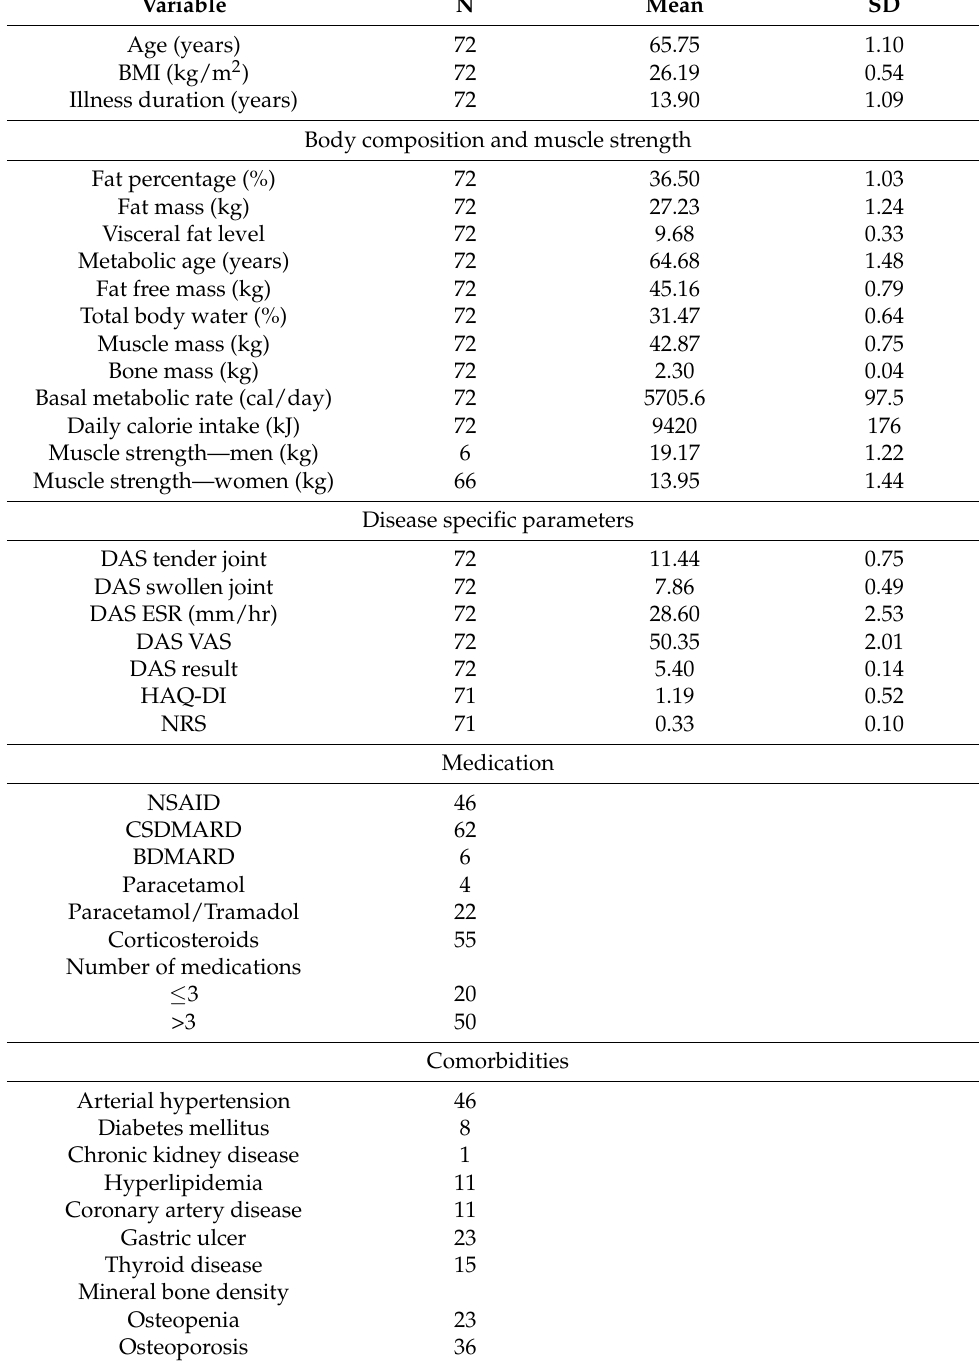
Table 1. Descriptive statistics of measured